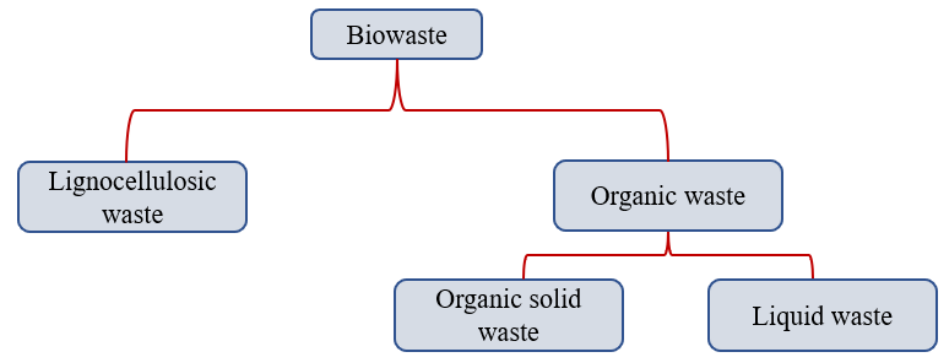
Figure 1. Classification of biomass waste.